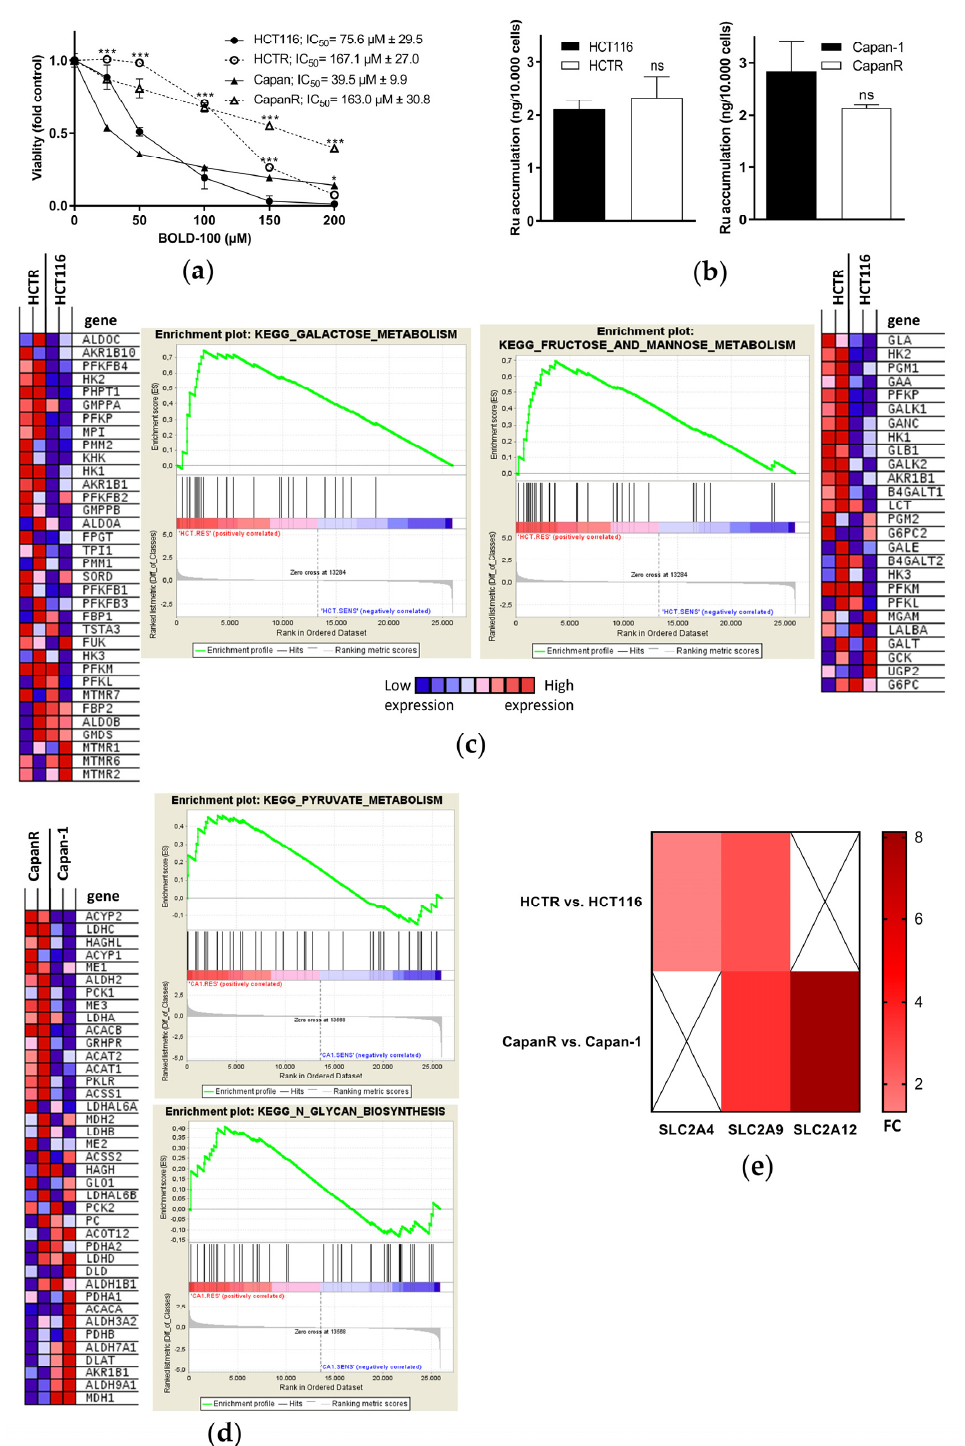
Figure 1. Whole genome gene expression profiling identifies transcriptional deregulations of cellular carbohydrate metabolism as a response to BOLD-100 and in acquired resistance against BOLD-100 in HCT116 and Capan-1 cells. ( a ) Cell viability of acquired BOLD100-resistant HCTR and CapanR cells as compared to their respective parental HCT116 and Capan-1 cells upon 72 h of treatment with increasing BOLD-100 concentrations, as determined by MTT assay. The statistical significance of